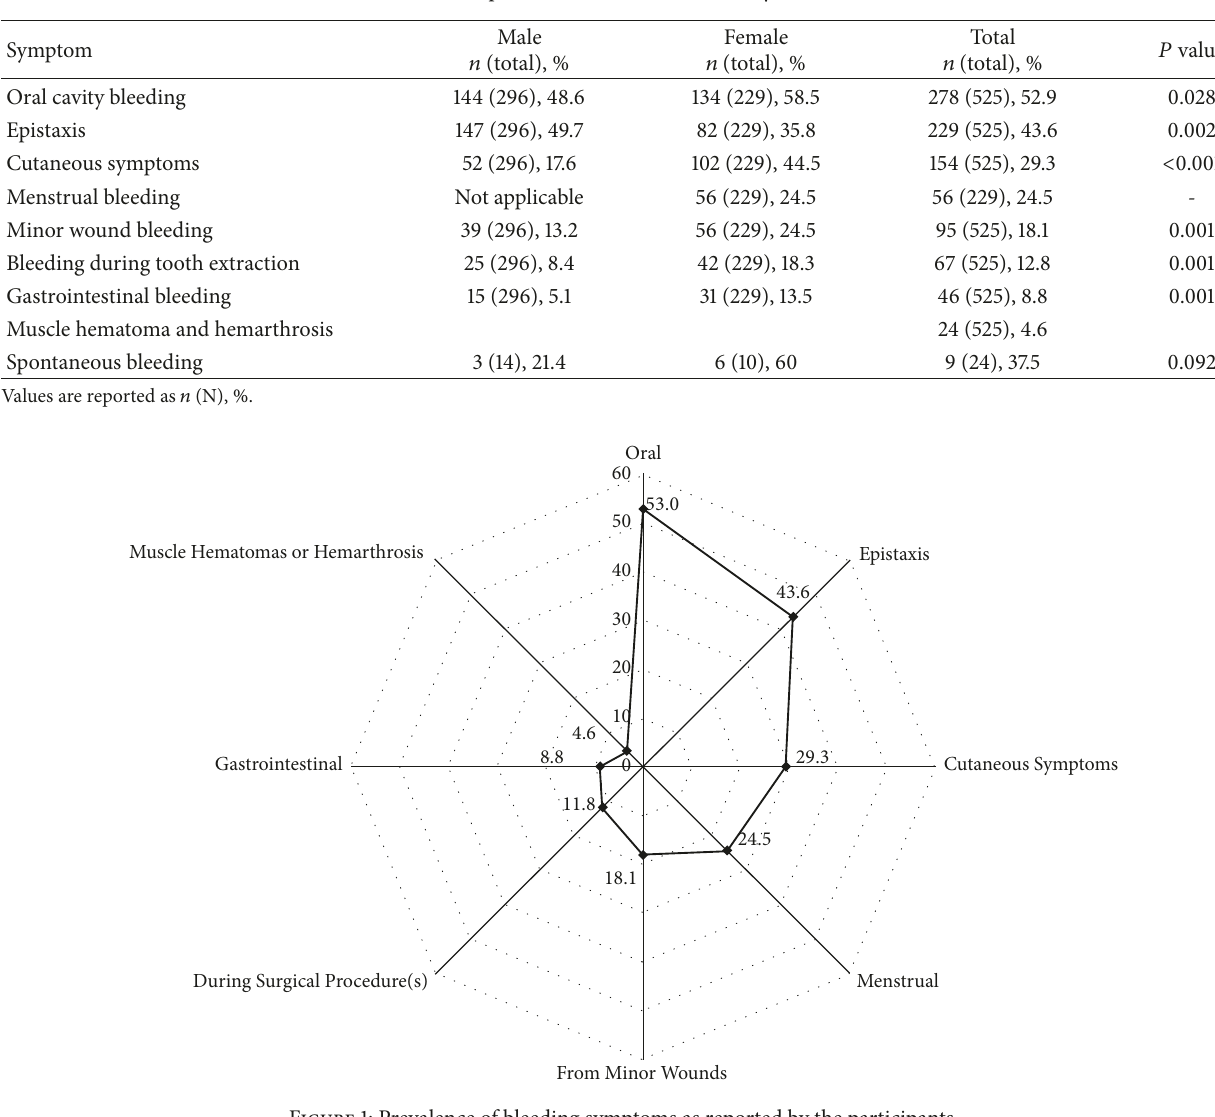
Table 3: Responses to Phase II of the Survey (𝑛 = 525) .